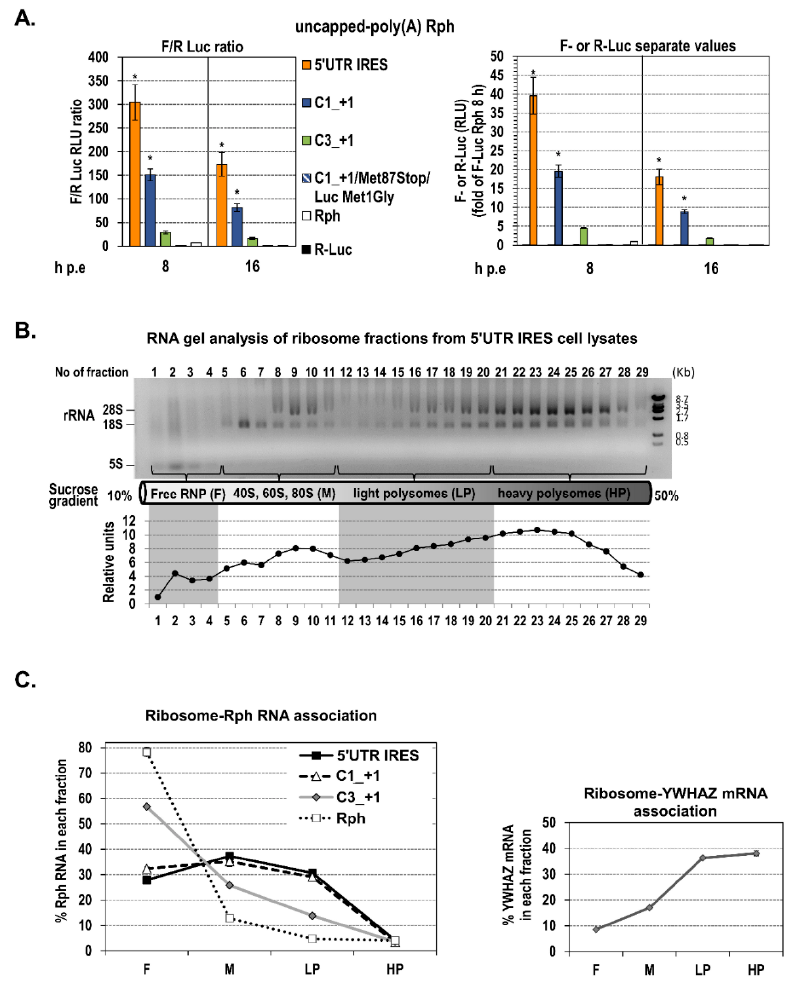
Figure 4. Distribution of the Rph constructs-derived RNAs in the ribosomal fractions of Huh-7 cells. ( A ) Ratio F / R ( left ) or separate values ( right ) of F-Luc and R-Luc activities determined in Huh7 cells after electroporation with in vitro transcribed, uncapped, and polyA-tailed RNA of the Rph-based 5 (cid:48) -untranslated region (5 (cid:48) UTR) internal ribosome entry site (IRES), C1_ + 1, C3_ + 1, or C1_ + 1 / Met87stop / Luc Met1Gly constructs or the empty vector Rph, 8 and 16 h post-electroporation (p.e). Values are means ± SD of three independent experiments in triplicate and expressed as RLU ratio ( left ) or as separate F-Luc and R-Luc RLUs ( right ). F-Luc and R-Luc values for all constructs were expressed relative to the F-Luc value derived from cells transfected with the negative control Rph at 8 h p.t, which was set to one, and their ratios were calculated. * p < 0.001 vs. C3_ + 1 and vs. Rph transfected cells (Student’s t test). ( B , C ) The time-point of 16 h p.e. was selected to examine the loading of ribosomes on the uncapped RNAs of the Rph-based 5 (cid:48) UTR IRES, C1_ + 1, C3_ + 1 sequences and the respective empty vector Rph after electroporation in Huh7 cells. Cell lysates were subjected to sucrose density gradient ultracentrifugation. The distribution of ribosomal RNA along the collected fractions was determined by agarose gel electrophoresis ( B , top ) and quantified by Quantity One software ( B , bottom ). A representative gel analysis of three independent experiments is shown (of cell lysates from cells transfected with 5 (cid:48) UTR IRES RNA). The positions of fractions with free ribonucleoprotein complexes (F, fractions 1–4), 40S–60S–80S monosomes (M, fractions 5–11), light polysomes (LP, fractions 12–20), and heavy polysomes (HP, fractions 21–29) are depicted with arrows at the bottom of the gel, where a schematic of the 10–50% sucrose gradient is presented. Fractions from the above groups were pooled, total RNA was extracted, and the ribosome–HCV RNA association was analyzed with RT-qPCR ( C left ). The distribution of the mRNA of the housekeeping gene 14-3-3-zeta polypeptide (YWHAZ) was also analyzed, as a control ( C right